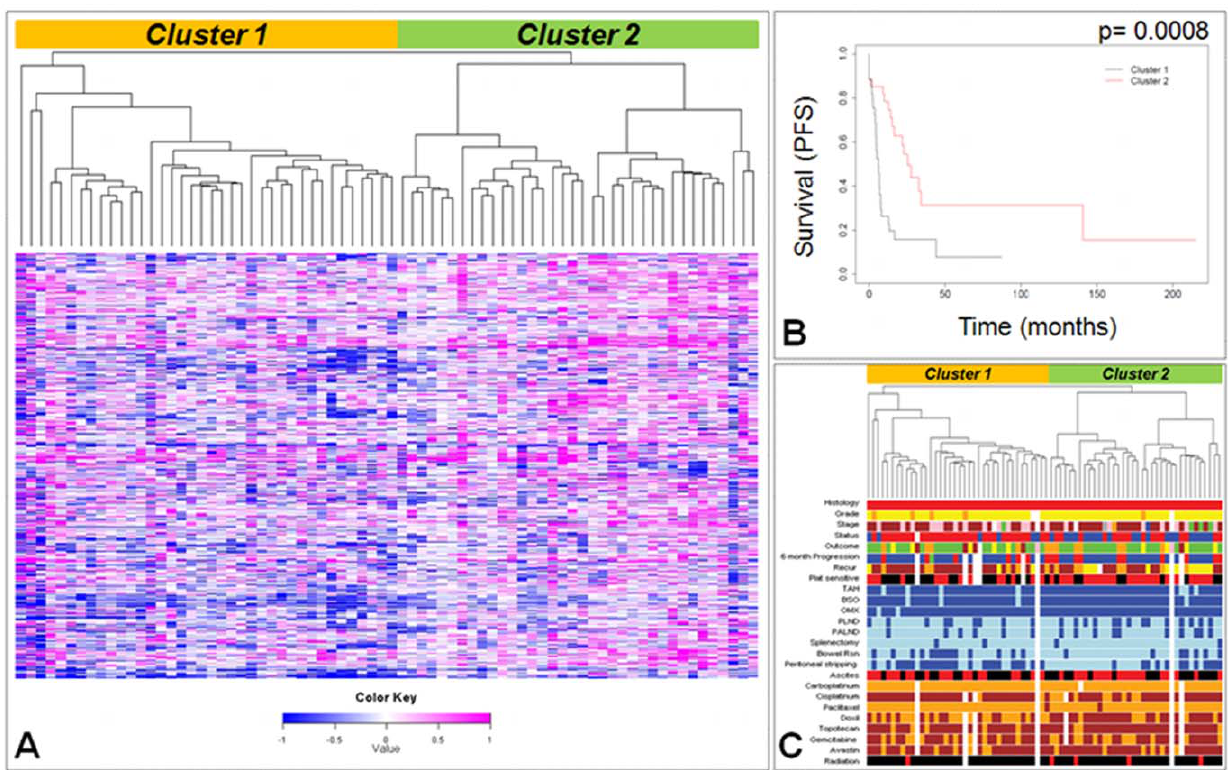
Figure 2. Unsupervised hierarchical clustering of CNAs identifies distinct patient subgroups. A ) Unsupervised hierarchical clustering of raw log2 ratios derived from 72 serous type ovarian cancers. Copy number values are color coded as follows: blue (loss), white (normal) and magenta (gain). The pattern of dendrogram suggests two major genomic subgroups within the grade 3 tumors. B ) PFS Kaplan-Meier plot for the two subgroups. C ) Comparison of clinical characteristics between the patient subgroups. Histology: red=serous; Grade: orange=grade 2, yellow=grade 3; Stage: red=Ic, blue=II, green=IIc, yellow=IIIa, orange=IIIb, brown=IIIc, pink=IV, dark gray=IVa; Status: red=evidence of disease, blue=no evidence of disease; Outcome: green=complete remission, orange=progression, yellow=partial remission, brown=lost to follow up, pink=benign; 6 month progression: red=yes, blue=no, green=P (progression); Recurrence: brown=yes, orange=persistent disease, yellow=no; Platinum response: red=sensitive, black=resistant; Drug: blue=yes, light blue=no; Ascites: red=yes, black=no; Chemo: orange=yes, brown=no; Radiation: red=yes, black=no; General: white=n/a and/or blank.